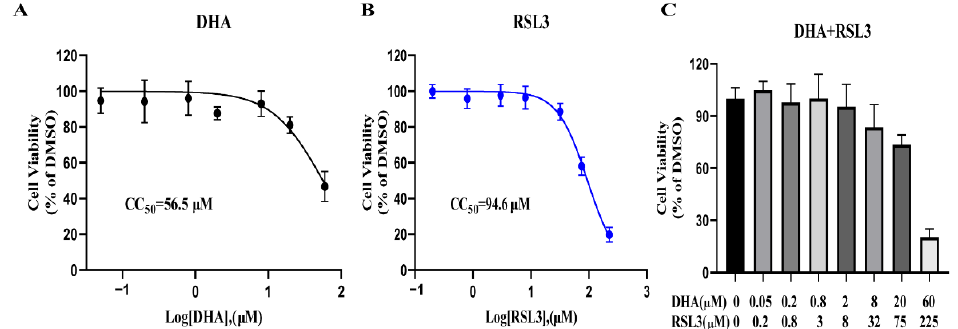
Figure 8. Cytotoxicity of RSL3 and DHA on Vero cells. The cytotoxicity of 0.05–60 µ M DHA ( A ), 0.2–225 µ M RSL3 ( B ), and 0.2–225 µ M RSL3 plus 0.05–60 µ M DHA ( C ) on Vero cells was measured using CCK-8 reagent, respectively. The concentration combination ranged from 0.25 to 300 × EC 50 DHA and RSL3. DMSO was set as a control. Cell viability rate = OD RSL3/OD DMSO. This experiment was performed in triplicate.